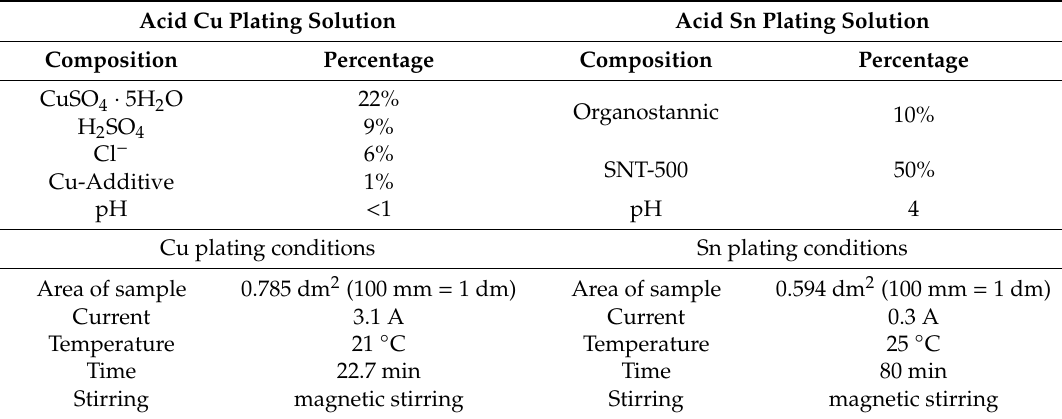
Figure 2. The sample was cut into three different sizes: ( a ) 5:5 size; ( b ) 3:7 size; ( c ) 1:9 size; ( d ) actual samples. Table 1. Conditions for electroplating tin and copper films.